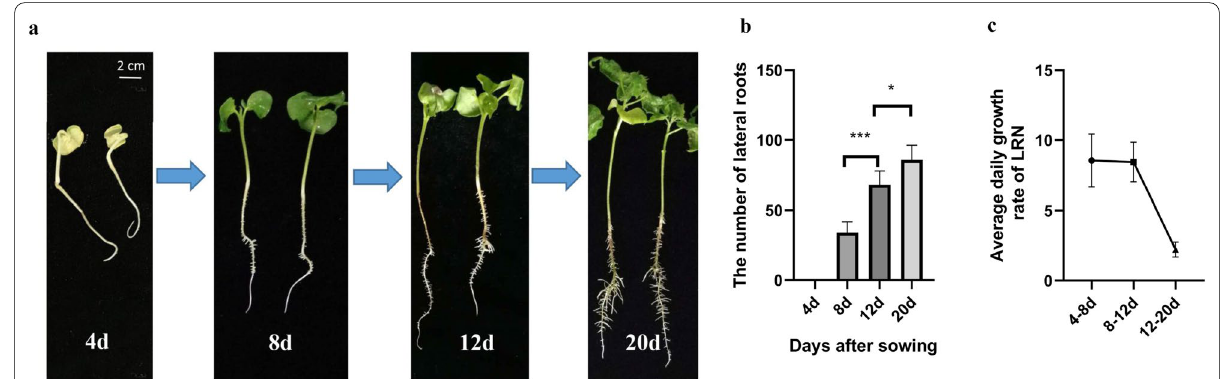
Fig. 1 Phenotype of lateral root number at 4, 8, 12, and 20 days after planting for Asian cotton standard line Shixiya1. a Phenotype pictures of lateral root development. b The numbers of lateral roots. c Average daily growth rate of lateral root number (LRN). * and ***: significant at P < 0.05 and P < 0.001,